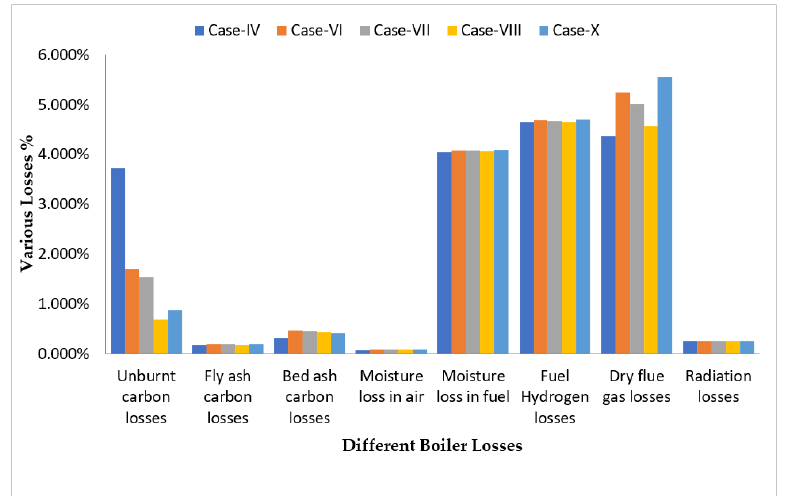
Figure 22. Different losses from the boiler for all